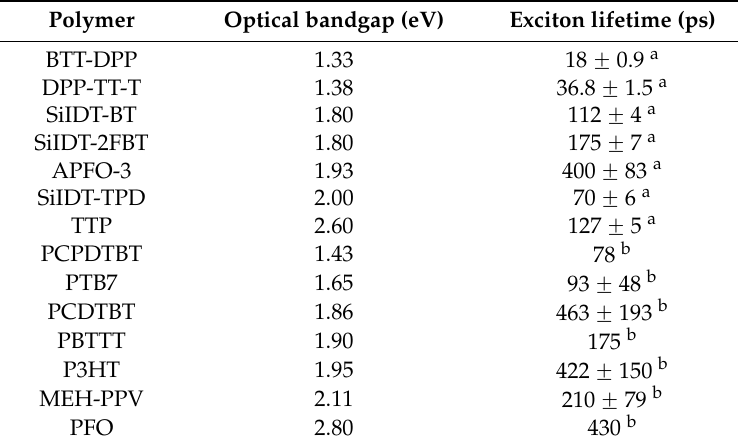
Table 1. Optical bandgaps and exciton lifetimes of the polymers analyzed in this study. The full names of the polymers are included in the Materials and Methods